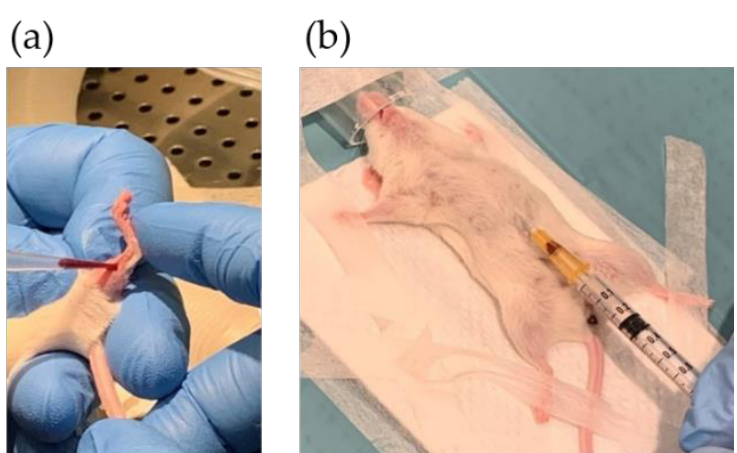
Figure 5. Blood sampling by puncturing: ( a ) vena saphena and ( b ) the heart. At the endpoint, the mice were anesthetized, and blood was collected from the main vein/heart (Figure 5b) before euthanizing the mice by cutting the aorta. Whole blood was spotted on Whatman cards (50 µ L) for FA profiling. To prepare plasma, blood was drained from the vein and transferred to Microvette CB 300 capillary tubes with EDTA (Sarstedt, Nümbrecht, Germany). Samples were mixed, centrifuged (3000 rpm, 4 ◦ C, 10 min) and aliquoted. Whatman cards and plasma were stored at − 80 ◦